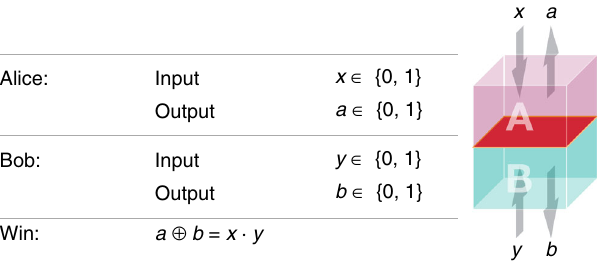
Fig. 1 The Clauser – Horne – Shimony – Holt game 34 . Alice and Bob input bits, separately, into their parts of the shared device. Each part of the device supplies an output. The game is won if a ⊕ b = x ⋅ y . The optimal winning probability in this game for a classical device is 75%. A quantum device can get up to approximately 86% by measuring the maximally entangled state ffiffiffi p Φ þ j i = 00 j i þ 11 j ið Þ = 2 with the following measurements: Alice ’ s measurements x = 0 and x = 1 correspond to the Pauli operators σ z and σ x , respectively, and Bob ’ s measurements y = 0 and y = 1 to σ z þ σ x ð Þ =